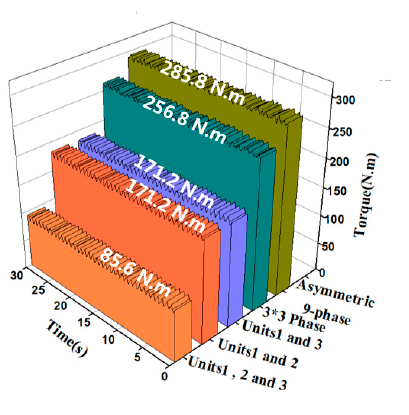
Figure 4. No-load back EMF of 3 *three-phase and asymmetric 9-phase PMSG.